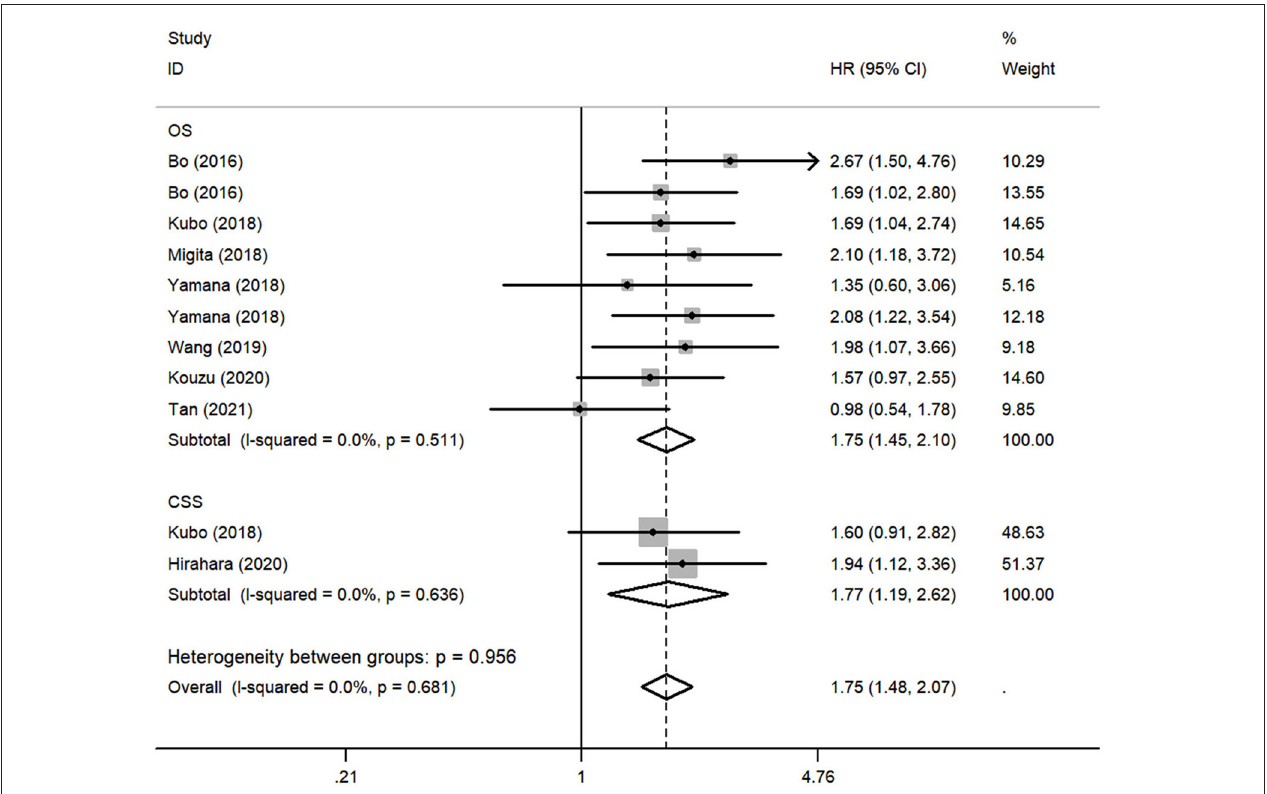
FIGURE 2 | Forest plot of pooled hazard ratio (HR) of geriatric nutritional risk index (GNRI) in predicting survival outcomes in esophageal cancer (EC).